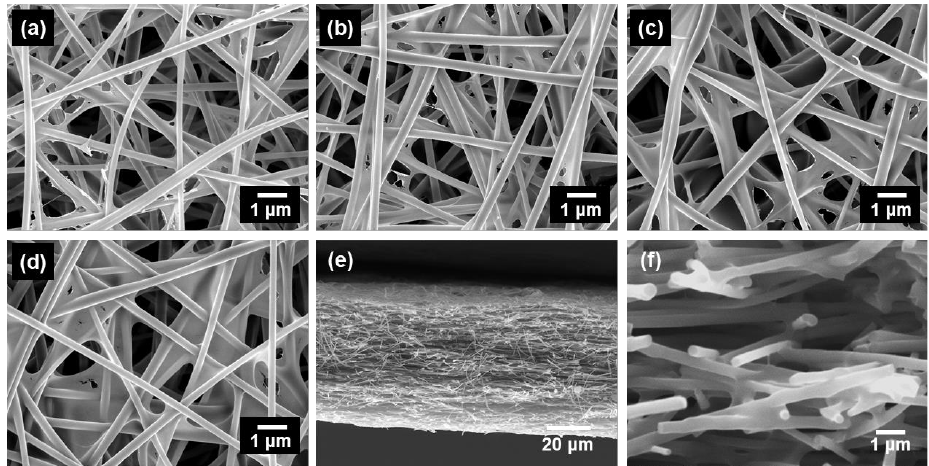
Figure 4. FE-SEM images of composite NHMs with different PVA loading amounts of ( a ) 1.0, ( b ) 1.5, ( c ) 2.0, ( d ) 2.5 wt% under a fixed CCA to PVA content ratio of 4:1. ( e , f ) Cross-sectional images of the representative NHMs sample.